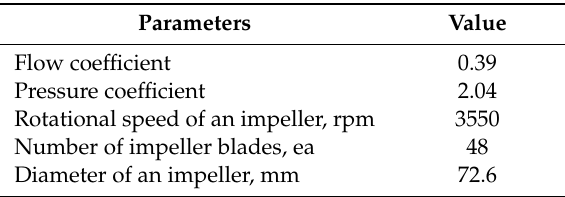
Figure 1. Configuration of the reference microbubble pump: ( a ) front view; ( b ) conventional regenerative impeller. Table 1. Specifications of the reference microbubble pump